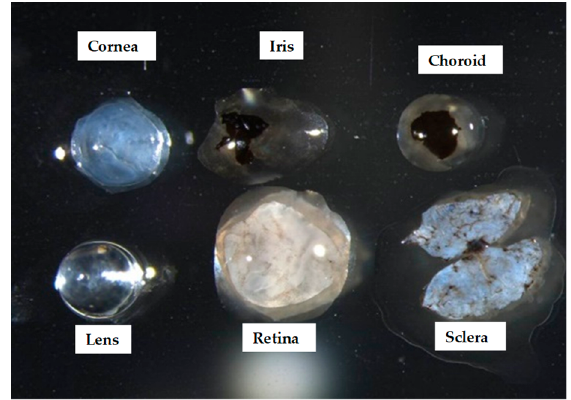
Figure 3. Ocular component tissues. The individual components of the eyeball are shown as separated into the cornea, iris, lens, retina, retinal pigment epithelium (RPE)/choroid, and sclera. The RPE/choroid and the sclera components were removed as delicately as possible using surgical scalpels. Table 1. The numbers of differentially expressed microRNAs (miRNAs) affected by myopia induction in the individual ocular components.